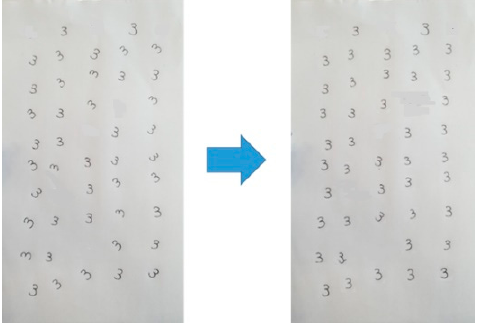
Figure 16. Tilt correction examples of “3” following the proposal ( left : original, right : tilt correction results).